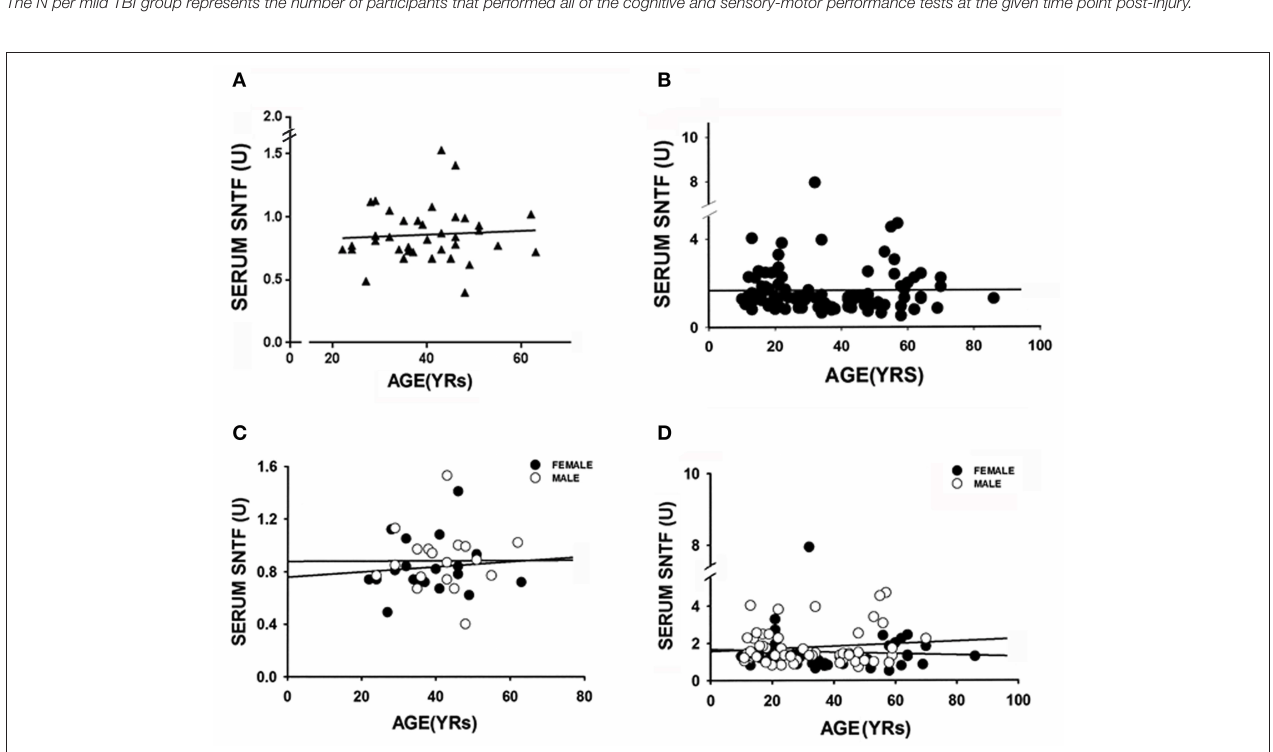
FIGURE 1 | Neither age nor sex affects serum SNTF levels in either healthy controls or acutely following mild TBI. Each study participant was evaluated for serum SNTF a minimum of 4 times. Relationships between serum SNTF, age and sex were evaluated by regression analysis and Mann-Whitney U -test. (A) Serum SNTF concentration is depicted vs. the age of 40 healthy adult control subjects. Linear regression analysis shows there is no relation between serum SNTF and adult age in non-neurologic injury controls. (B) Serum SNTF concentration on the day of injury is depicted vs. the age of 96 mTBI study participants. Linear regression analysis shows there is no relation between serum SNTF on the day of mTBI and the age of the patient. (C) Serum SNTF is depicted as a function of age of healthy adult control males and females. Once again, there is no appreciable change in SNTF of either males (open circles; n = 20) or females (filled circles; n = 20) with